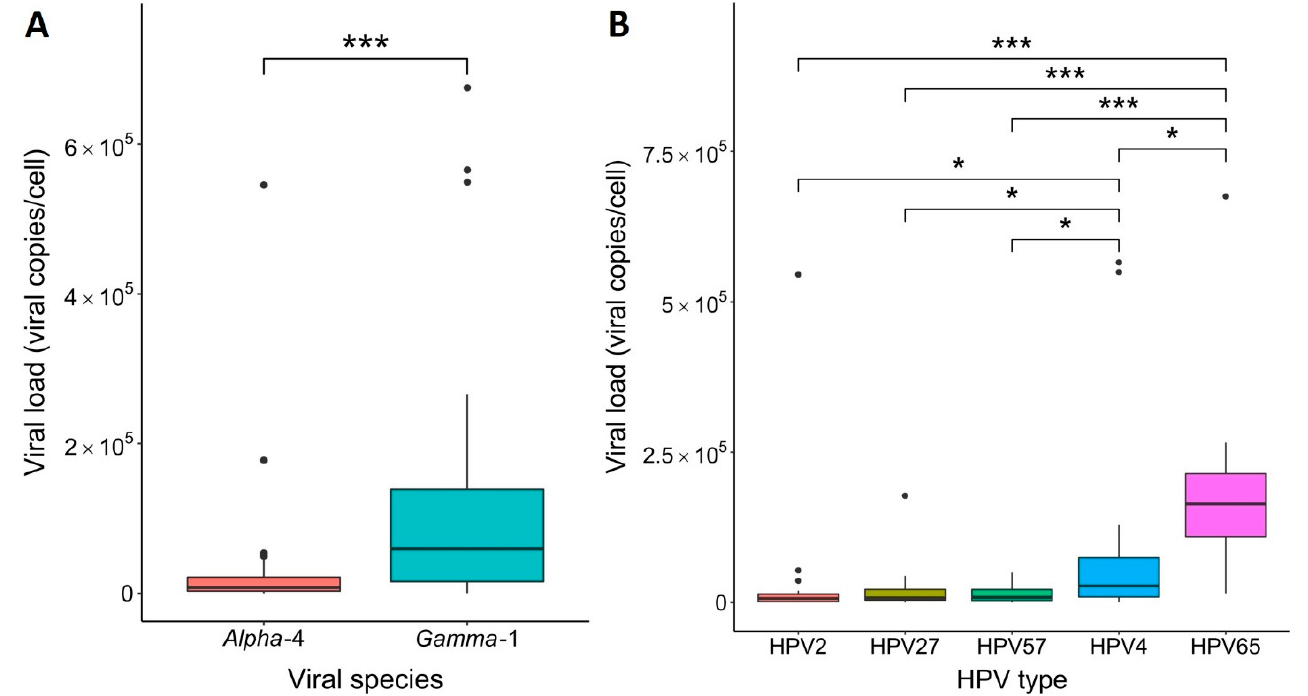
Figure 3. Estimated cellular viral loads of the most frequent causative human papillomaviruses (HPVs) in common warts. ( A ) Comparison of viral loads of causative HPVs from the Alpha -4 (median viral load: 7.73 × 10 3 copies/cell) and Gamma -1 species (median viral load: 5.94 × 10 4 copies/cell). Statistical comparison was performed with the Mann–Whitney U test (***, p < 0.0001). ( B ) Comparison of viral loads among the five most frequent causative HPV types. The viral load of HPV4 (median viral load: 2.75 × 10 4 copies/cell) was significantly higher than the viral loads of HPV2 (median viral load: 6.73 × 10 3 copies/cell; *, p = 0.030), HPV27 (median viral load: 7.73 × 10 3 copies/cell; *, p = 0.026), and HPV57 (median viral load: 8.65 × 10 3 copies/cell; *, p = 0.017). The viral load of HPV65 (median viral load: 1.64 × 10 5 copies/cell) was significantly higher than the viral loads of HPV2 (***, p < 0.001), HPV4 (*, p = 0.014), HPV27 (***, p < 0.0001), and HPV57 (***, p <